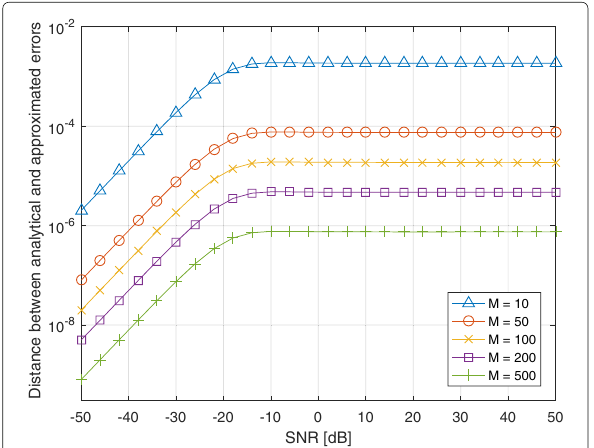
Fig. 8 Absolute distance between closed form and approximated MSE